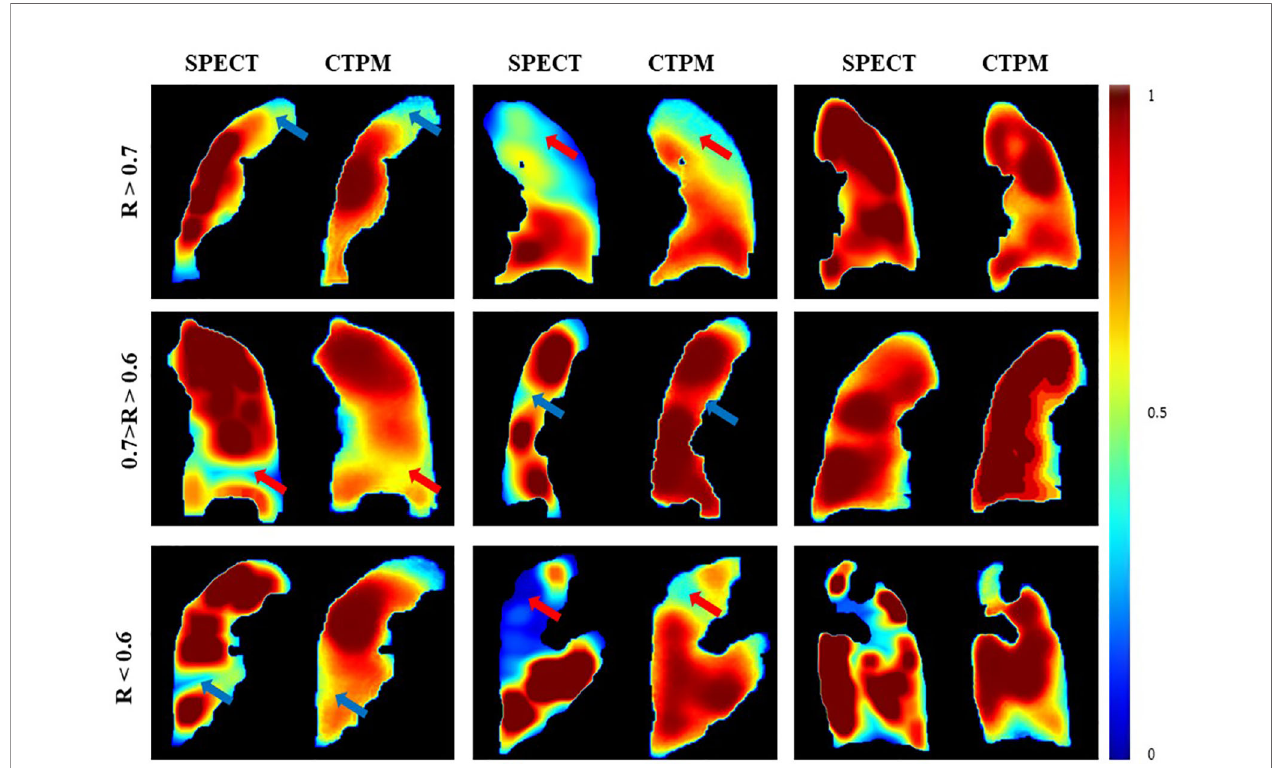
FIGURE 6 | Comparison of the SPECT perfusion and CTPM perfusion of representative cases in the testing group. The arrows point to the primary low functional